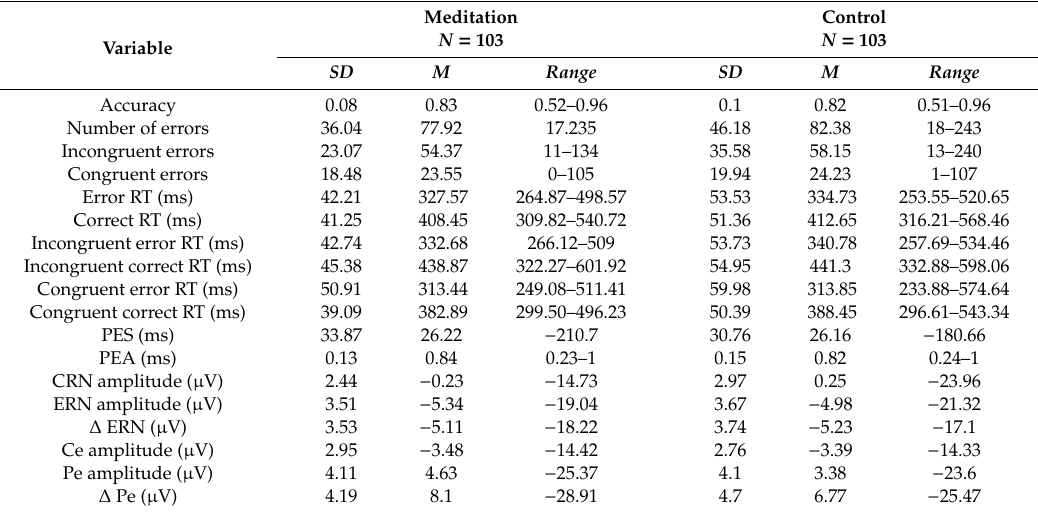
Table 2. Summary of behavioral and event-related potential (ERP) measures.